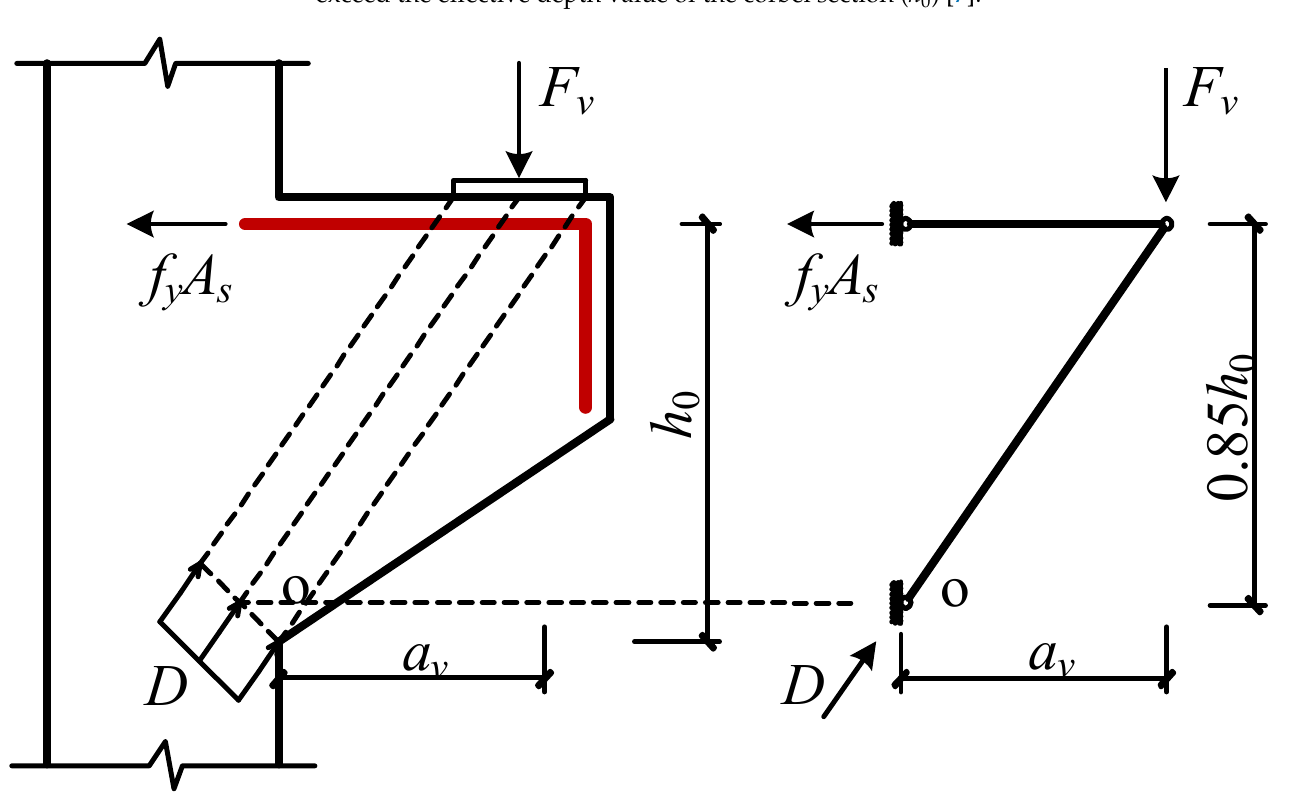
Figure 1. Triangular-truss method.